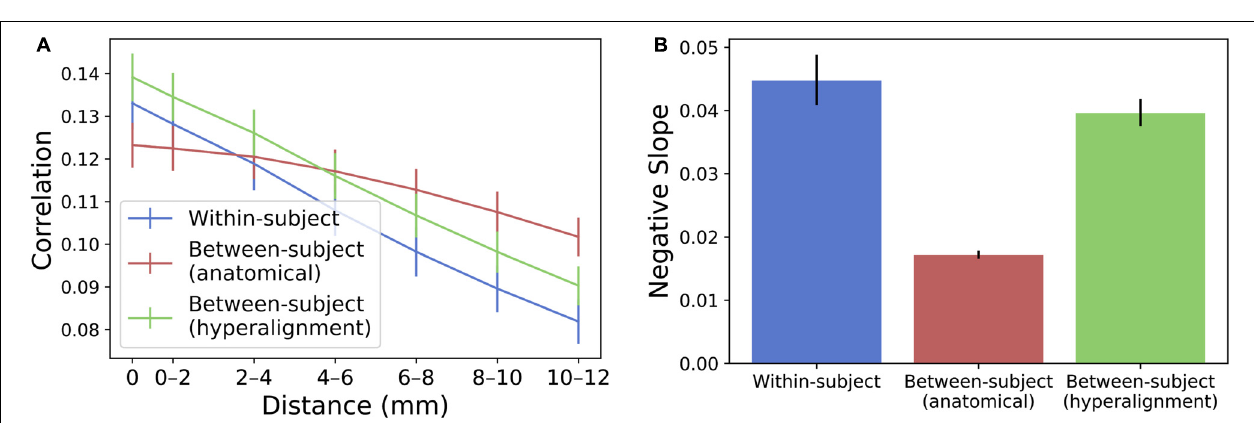
FIGURE 6 | Spatial PSF of semantic tuning. (A) Correlation between the predicted time series of one vertex and the actual time-series of its neighboring vertices up to 12 mm away. Correlations were aggregated based on distance from the central vertex of interest and averaged across vertices and subjects. Error bars denote 68% confidence intervals (standard error of the mean). (B) The within-subject and hyperaligned between-subject models have the steepest slopes (negative of the slope based on logarithmic curve fitting). Error bars denote 95% confidence intervals obtained by bootstrapping subjects 20,000 times with